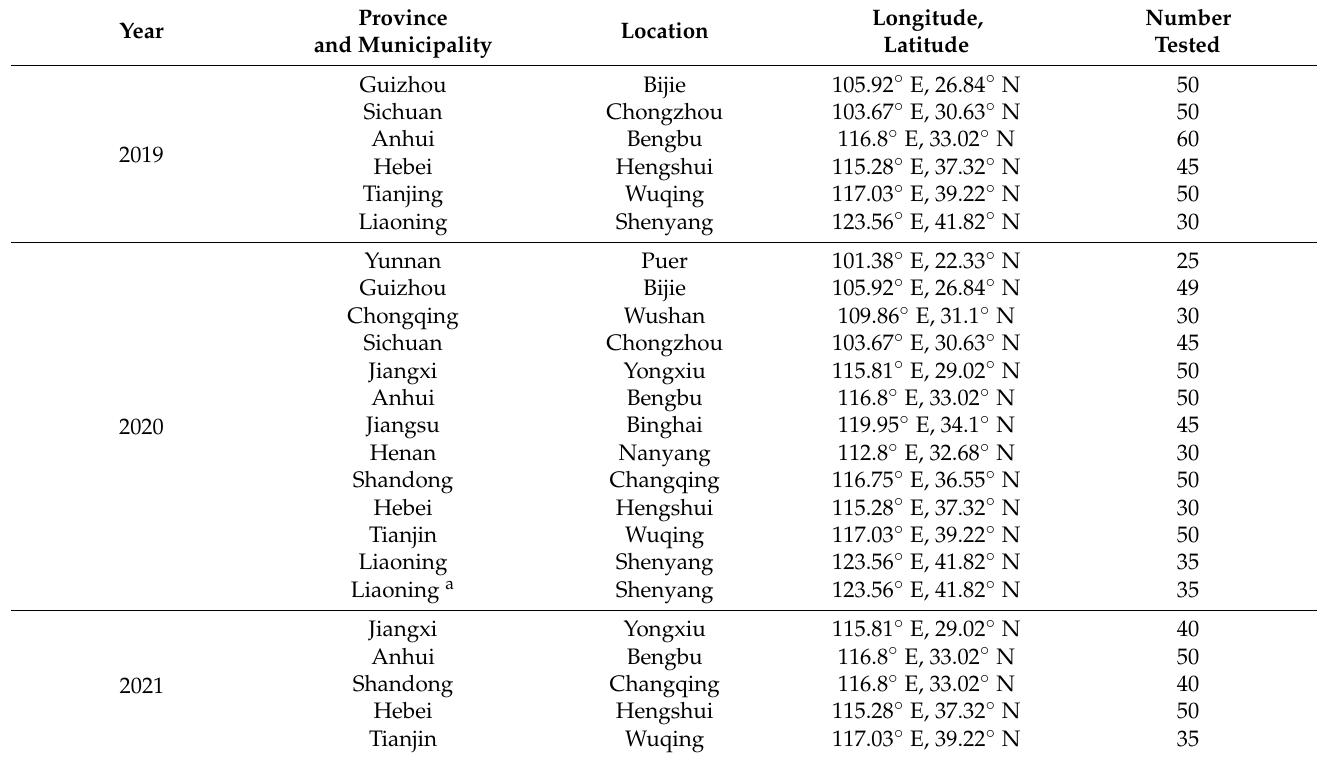
Table 1. Location and number of Ostrinia furnacalis samples collected in 2019–2021 in